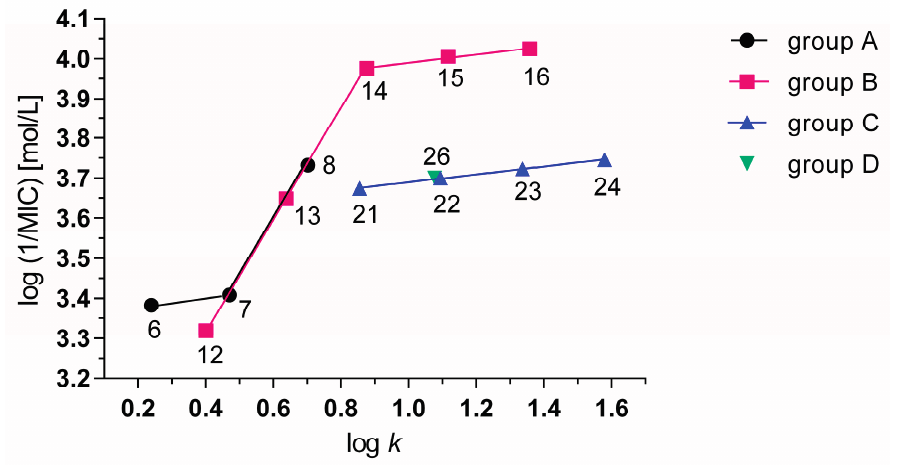
Figure 2. Dependence of antimycobacterial activity of tested compounds against M. tuberculosis H37Rv on log